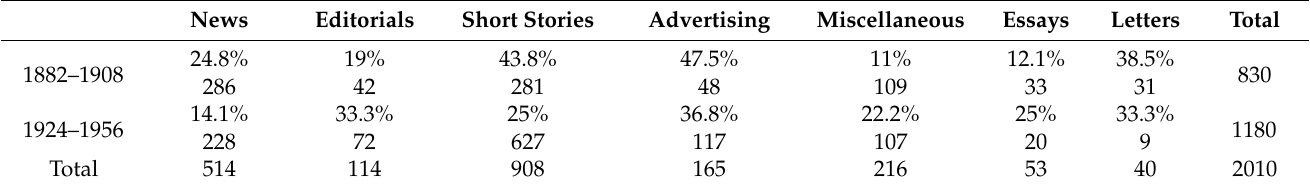
Table 10. Distribution of overt SPP tokens across journalistic genres for each period